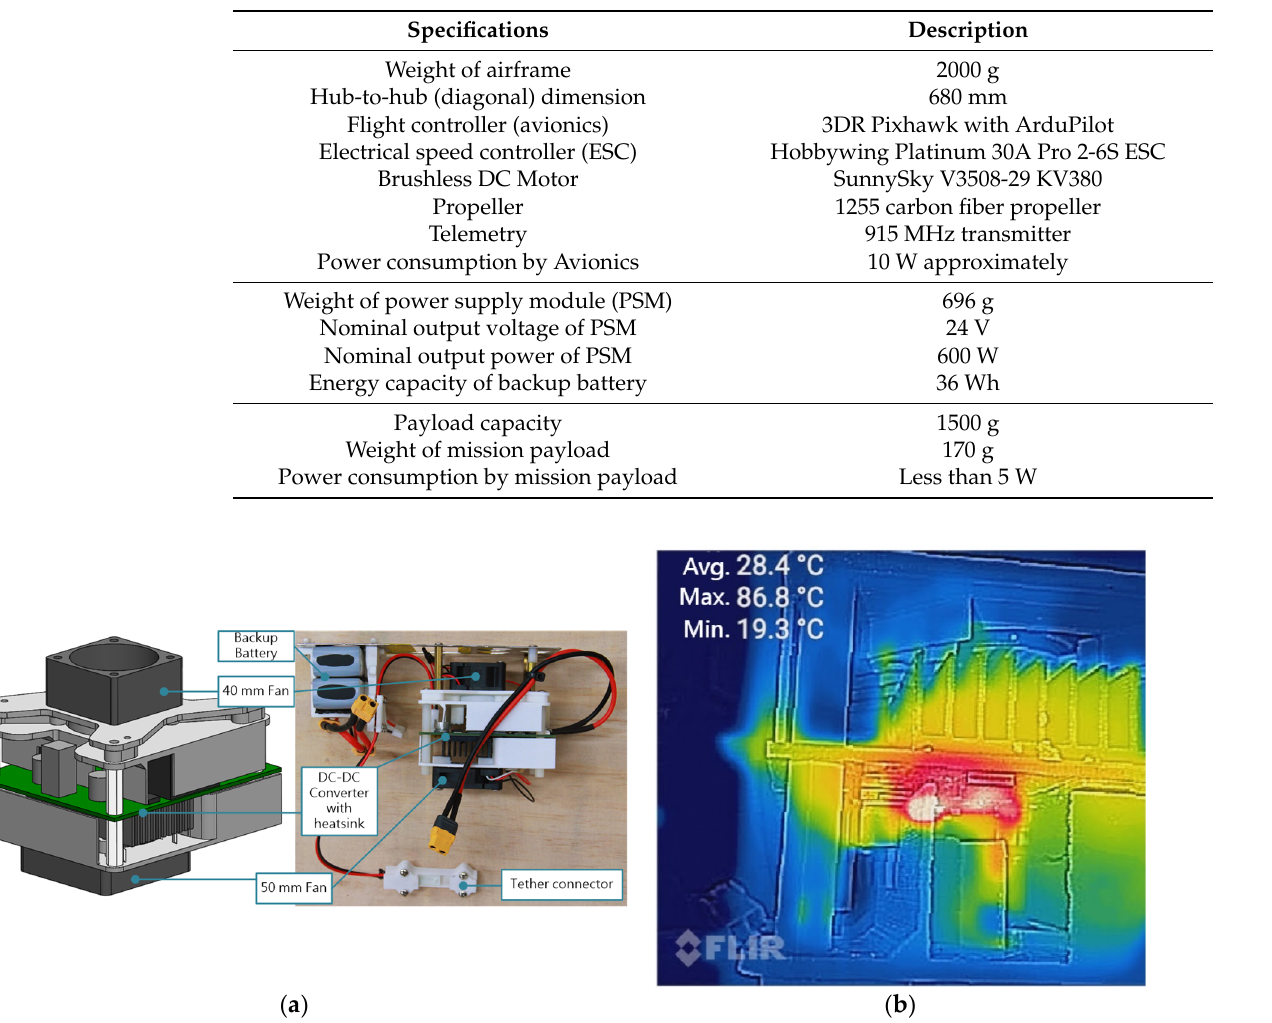
Table 2. Specifications of the proposed hexacopter subsystem.